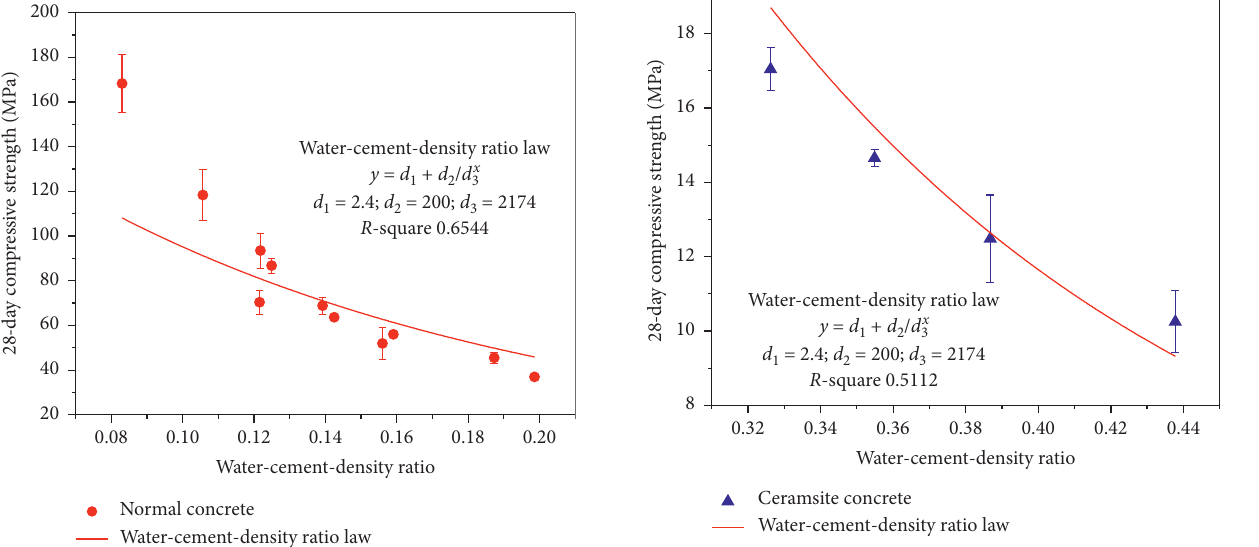
Figure 6: Simulation of water-cement-density ratio law for ceramsite